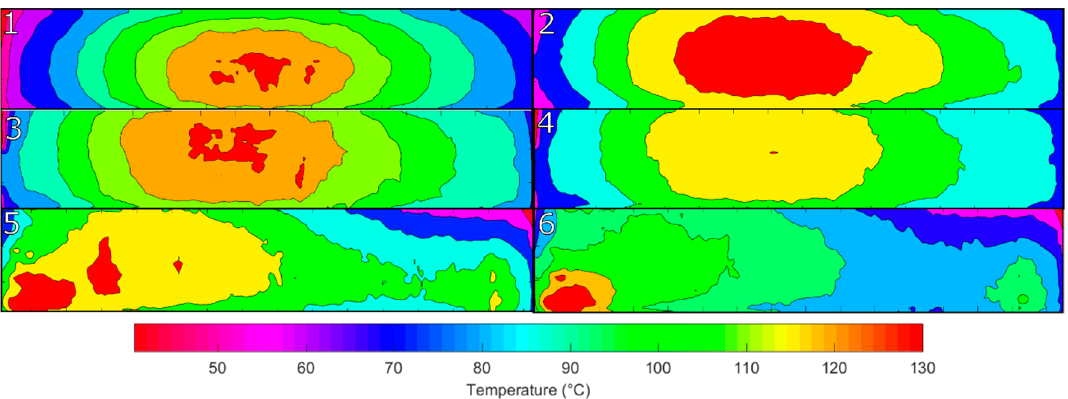
Figure 16. Greyscale method contour plots of the surface temperature profile measurements after each cycle of ablation using the Greyscale method.